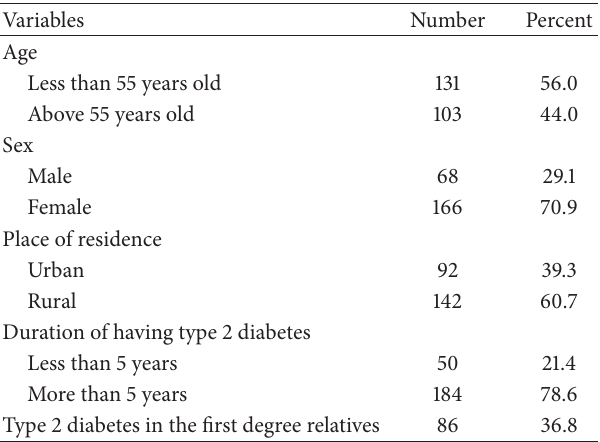
Table 1: Background characteristics of the studied type 2 diabetic